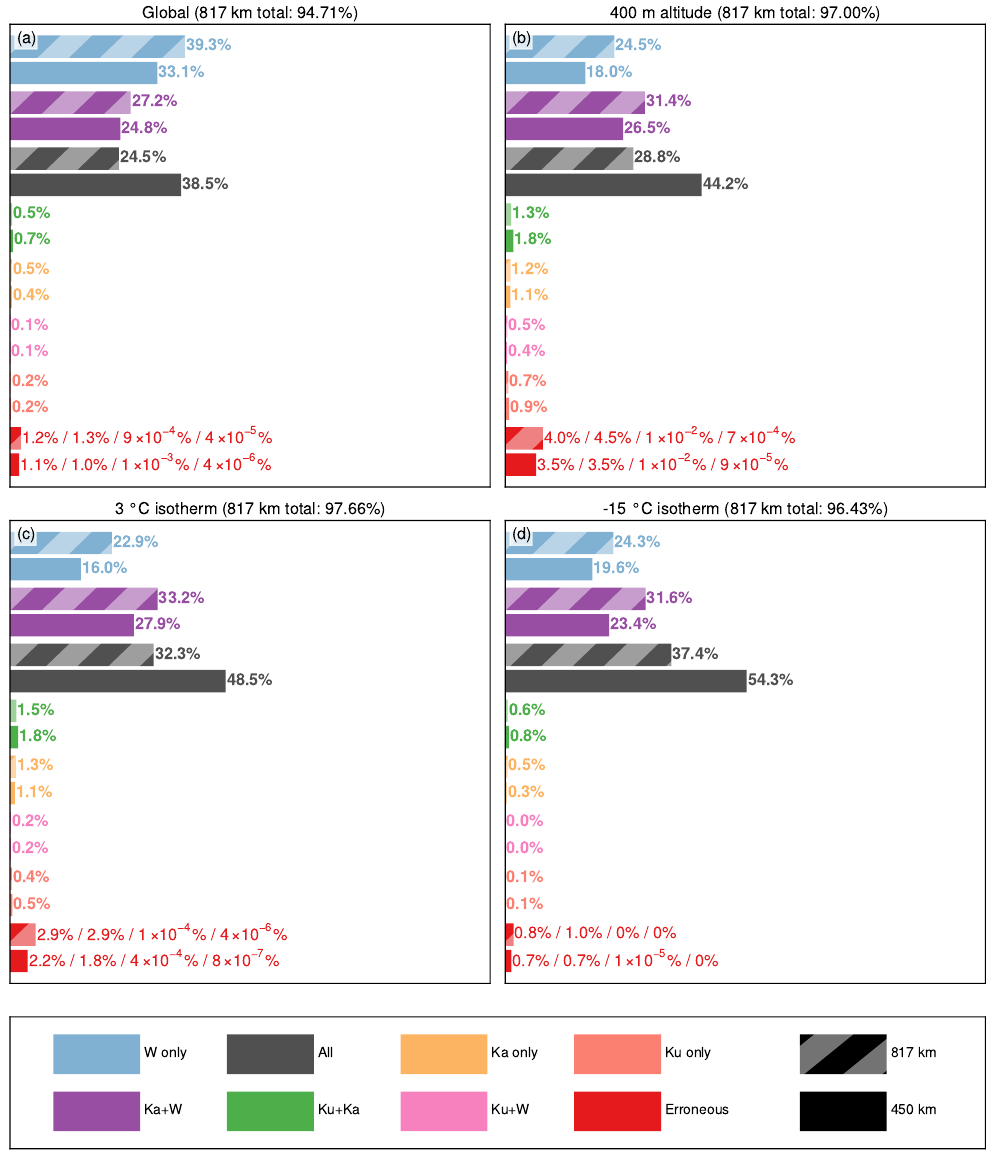
Figure 4. An overview of the detection rates at different radar bands. From top to bottom: blue, only W band detected; purple, Ka and W bands detected; dark gray, all bands detected; green, Ku and Ka bands detected; orange, only Ka band detected; pink, Ku and W bands detected; salmon, only Ku band detected; red, assigned to one of the error categories described in Sect. 4.1. The percentages following the red error category bars correspond to categories 1 (NUBF), 2 (severe NUBF), 3 (multiple scattering) and 4 (attenuation), in that order. The bars for the 450km orbit add up to 100%, while those for the 817km orbit add up to the percentage given above each subfigure. (a) The global total percentages from the entire model domain; (b) at the level 400m from the ocean or land surface; (c) at the 3 ◦ C isotherm; and (d) at the − 15 ◦ C